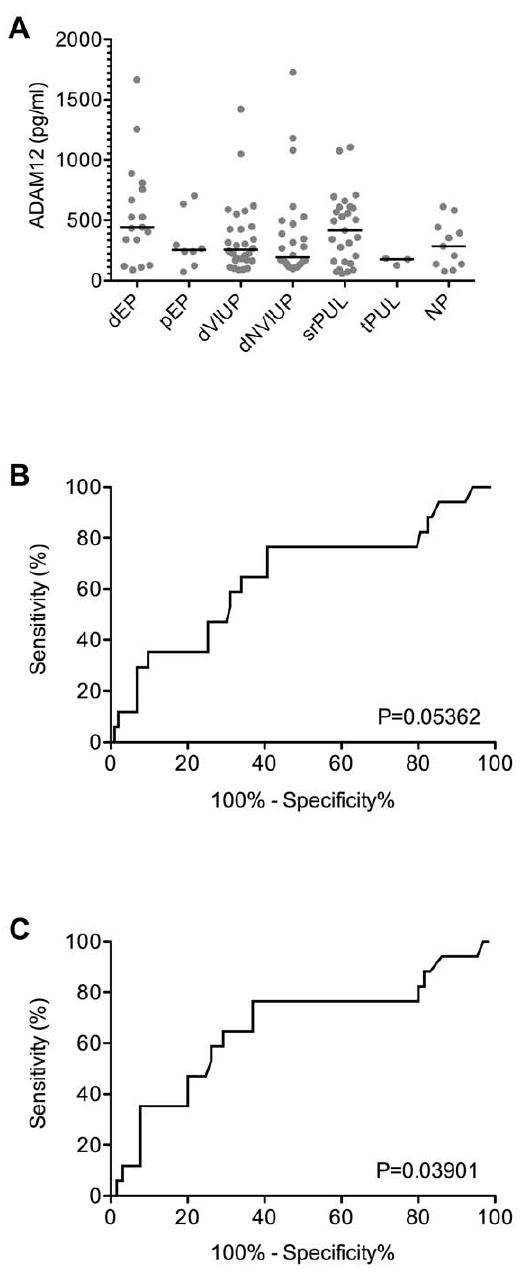
Figure 1. ADAM12 levels in sera collected from women at first presentation with a PUL, categorised according to final pregnancy outcome. Definite ectopic pregnancy (dEP: n=17), probable ectopic pregnancy (pEP: n=8), definite viable intrauterine pregnancy (dVIUP: n=28), definite nonviable intrauterine pregnancy (dNVIUP: n=26), spontaneously resolving PUL (srPUL: n=27), treated persistent PUL (tpPUL: n=3) and not pregnant (NP: n=11). A ROC curve was generated (‘ROC of ADAM12’) to compare serum ADAM12 concentrations in patients with a dEP versus all other outcomes. The analysis was repeated (‘ROC of ADAM12 -PUL Data’) after ‘ambiguous’ pregnancy outcomes (srPUL, tpPUL and pEP) were excluded.